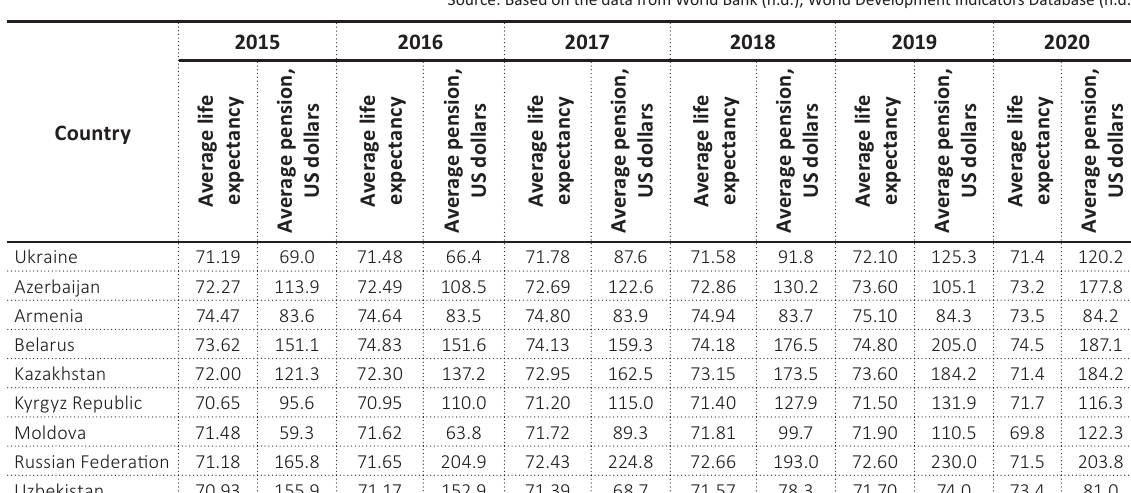
Table 2. Average life expectancy and average pension